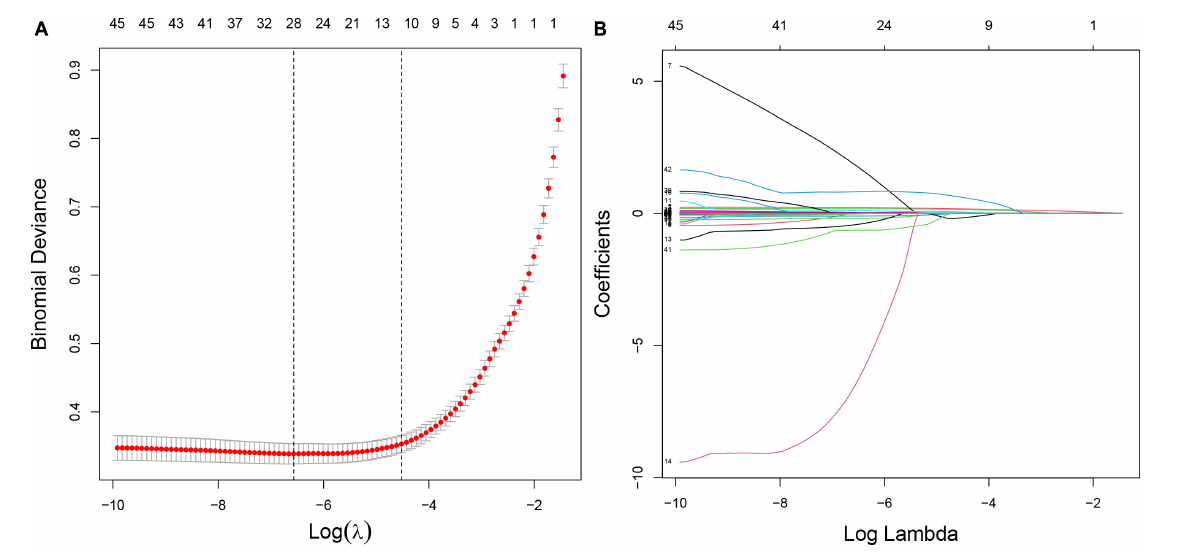
FIGURE2 Screening of characteristic variables using the LASSO regression analysis. (A) The selection of the best parameter (lambda) in the LASSO model uses 10-fold cross-validation with the lowest standard. The relationship curve between partial likelihood deviation (binomial deviation) and log (lambda) was plotted. Dotted vertical lines were drawn at the optimal values by using the minimum criteria and the 1 SE of the minimum criteria (the 1 SE criteria). (B) LASSO coefficient profiles of the 28 characteristic variables. A coefficient profile plot was produced against the log (lambda) sequence. LASSO, least absolute shrinkage and selection operator; SE, standard